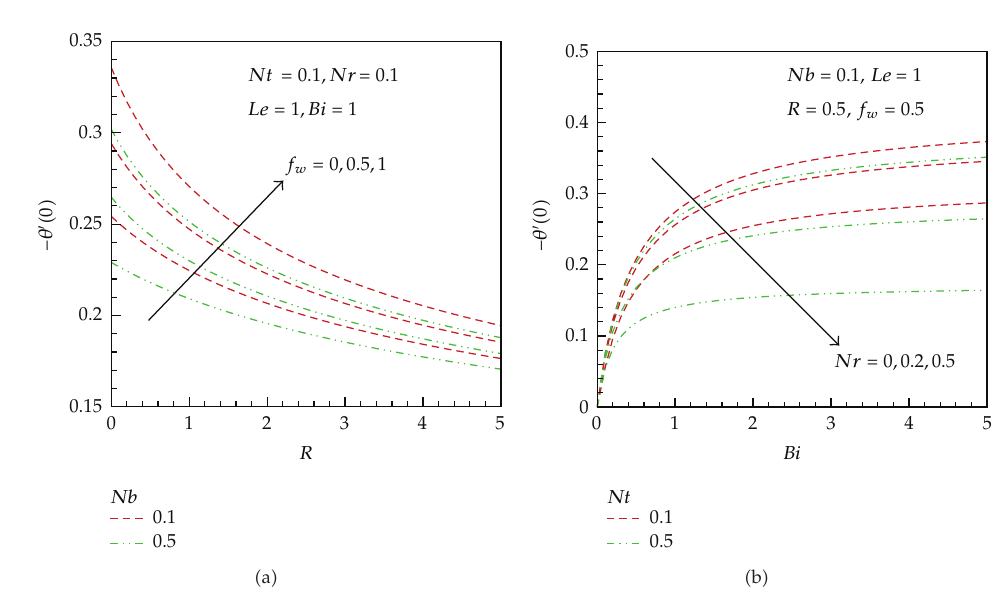
Figure 7: Variation of local heat transfer rate with (cid:3) a (cid:4) Brownian motion, suction/injection, and radiation parameters, (cid:3) b (cid:4) thermophoresis, buoyancy ratio, and Biot